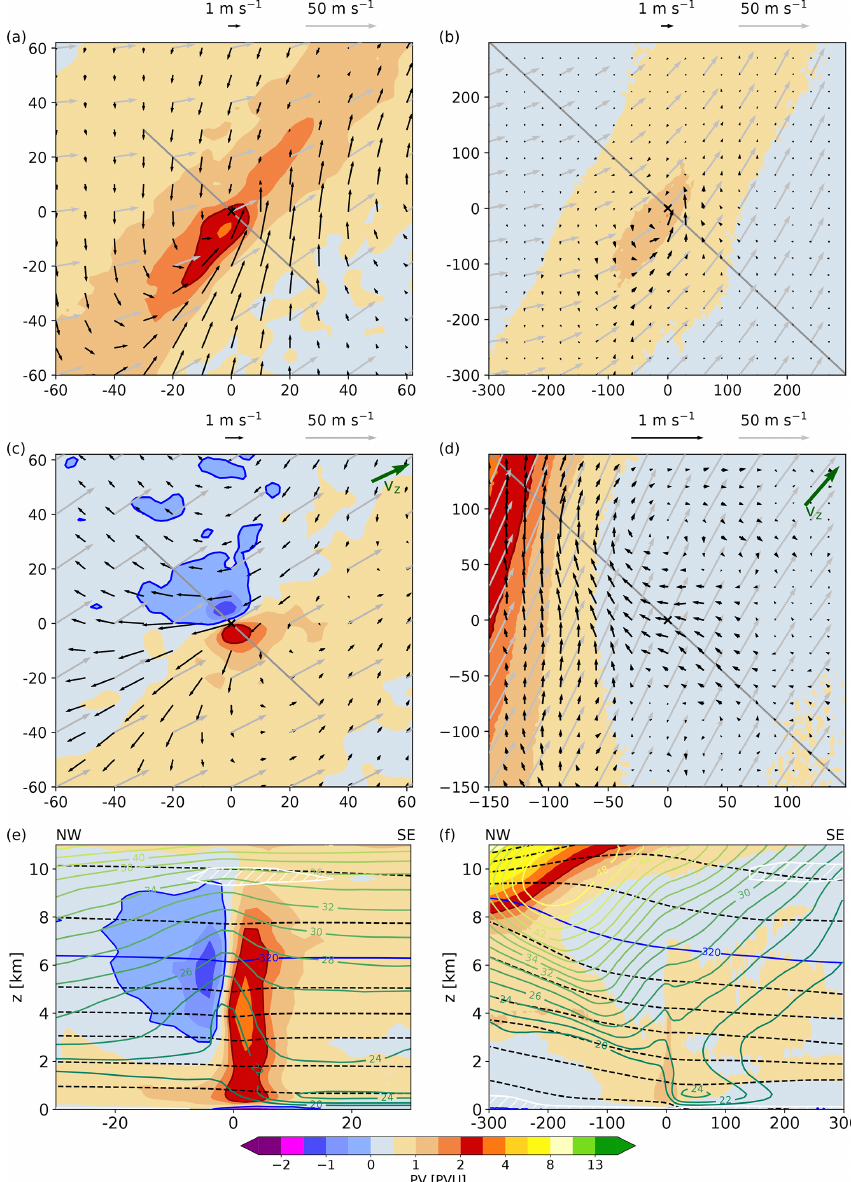
Figure 7. (a–d) Horizontal cross section composites of PV (colors, in PVU), wind speed (grey arrows, in ms − 1 ), and 2h circulation anomalies (black arrows, in ms − 1 ) at (a, b) 800m and (c, d) 320K for (a, c) convective WCB trajectories 30min after the start of the fastest 400hPa ascent and (b, d) slantwise WCB trajectories (b) 1h and (d) 10h after the start of the fastest 400hPa ascent. The green arrow in (c, d) shows the direction of the vertical wind shear vector ( v z ) between 4 and 10km height at the location of WCB ascent. The axes’ dimensions denote the distance from the WCB air parcel locations marked as “ × ” (in km). (e, f) Vertical cross section composites along the northwest–southeast orientated lines shown in (a, b) of PV (colors, in PVU), wind speed (green contours, every 2ms − 1 ), isentropes (dashed lines, every 5K), the 320K isentrope (blue line), and low static stability layers (d θ/ d z ≤ 2Kkm − 1 , white contour and hatching) for (e) convective WCB trajectories and (f) slantwise WCB trajectories 30min and 1h, respectively, after the start of the fastest 400hPa ascent. The x axis denotes the zonal distance from the WCB air parcel locations (in km). Note the different spatial dimensions for the convective and slantwise WCB